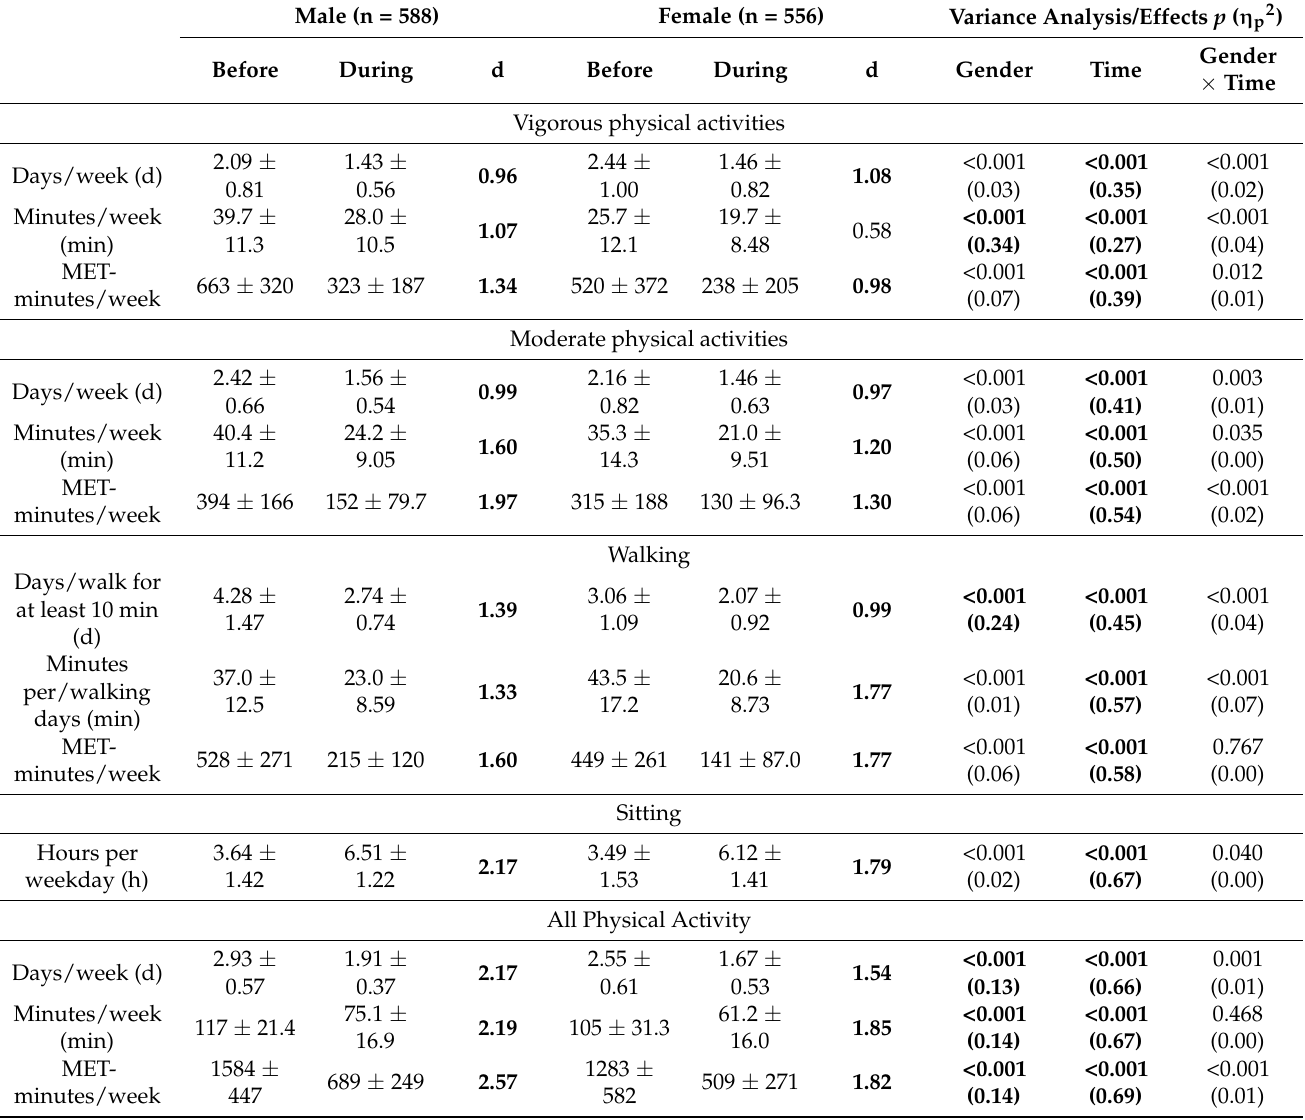
Table 3. Comparison of physical activity parameters and sedentary behavior (sitting time) between males and females before and during confinement. Values are given as mean ± SD. Significant effects (criteria of relevance: p < 0.05 and η p2 > 0.10 and d > 0.8) highlighted in